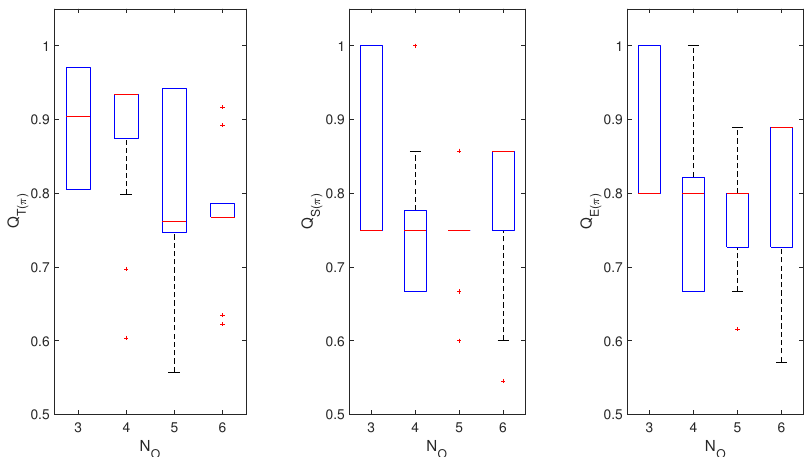
Figure 8. Boxplot of time, skill and equipment-related objectives for different independent runs of the algorithm and with different numbers of operators.